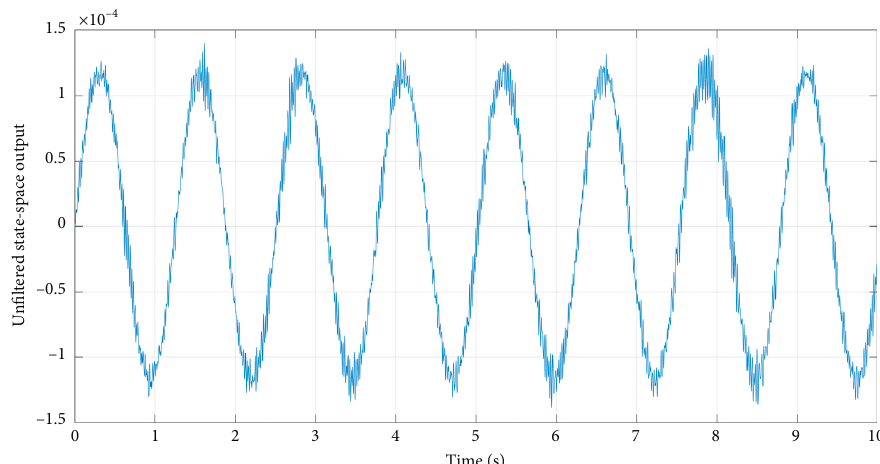
Figure 20: Unfiltered beam deflection at sensor location ( w ( x